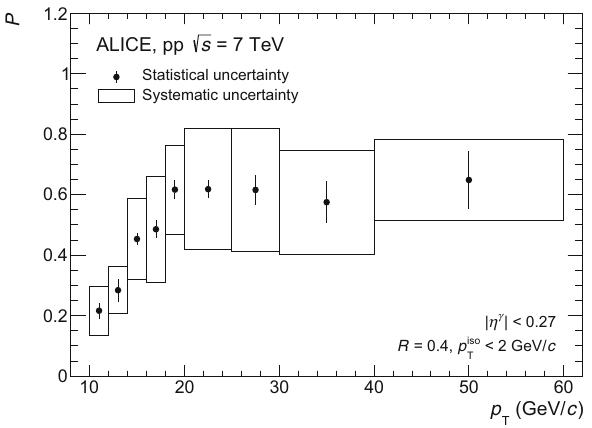
Fig. 5 Isolated photon purity as a function of photon p